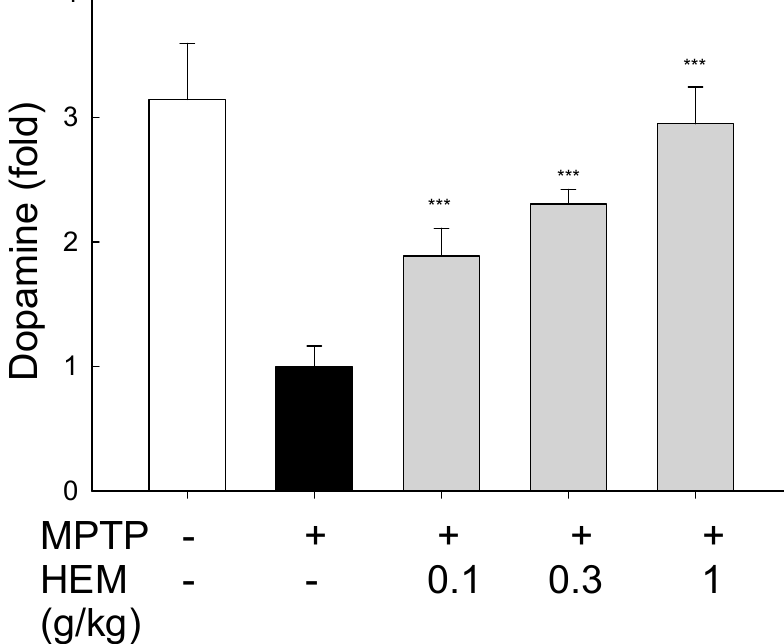
Figure 4. Dopamine levels in the substantia nigra of treated and untreated mice. A significant increase in the dopamine level was found in the HEM cotreated mice compared with the MPTP group in a dose-dependent manner. *** p < 0.001 compared with the MPTP-treated group.